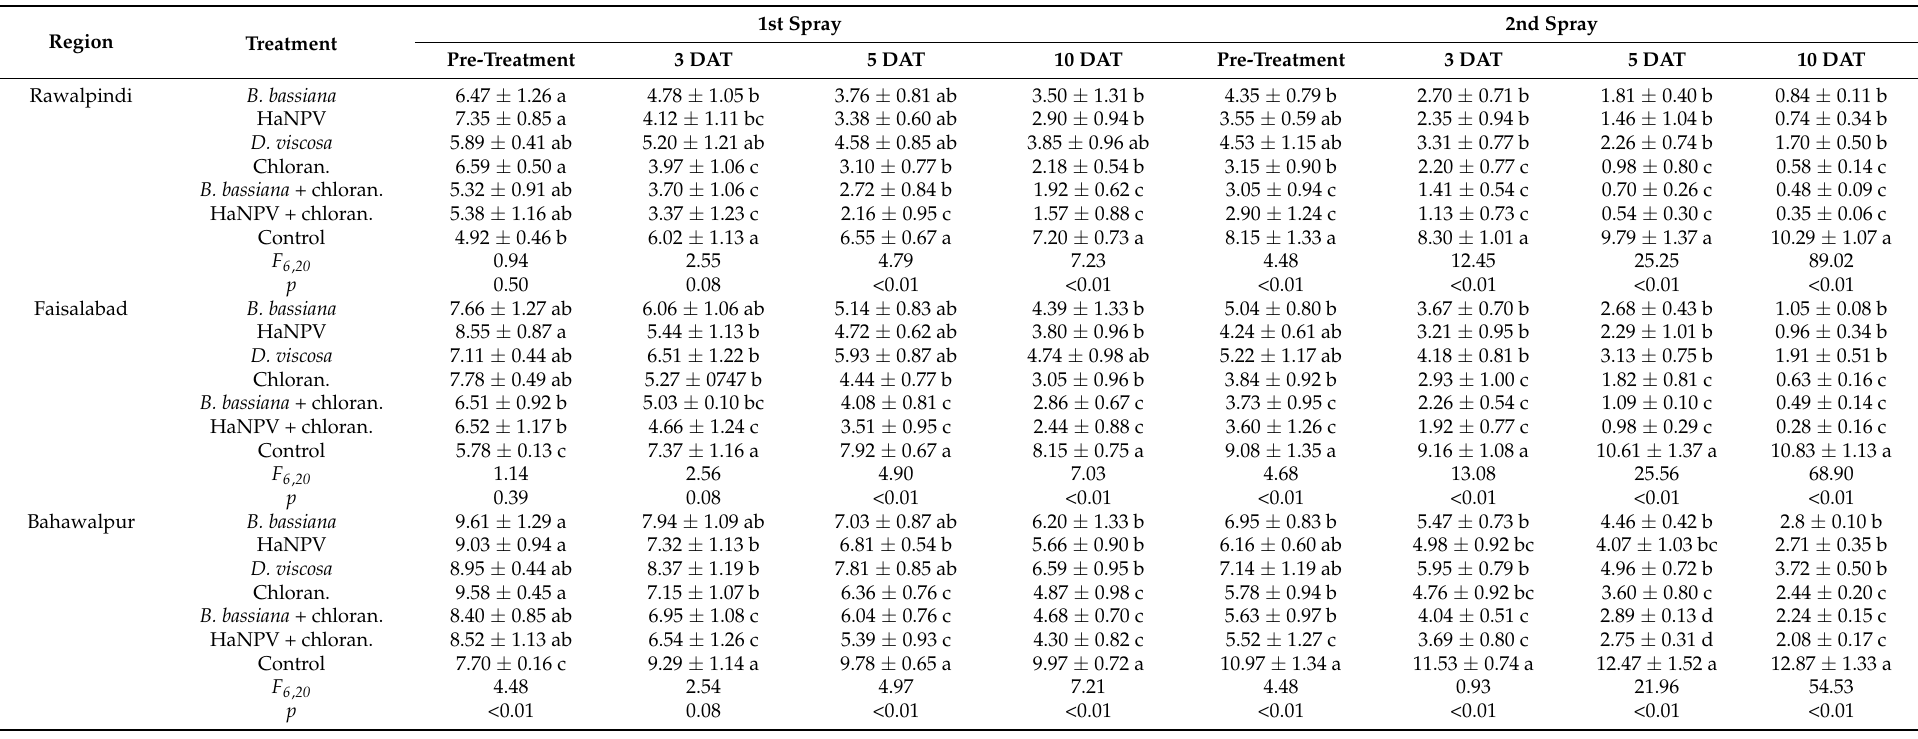
Table 2. Mean larval density (larvae per ten plants ± SE) of H. armigera following field application of different biorational and chemical control options based on B. bassiana ; HaNPV; D. viscosa and chlorantraniliprole (chloran.). Means for each location and sampling occasion followed by the same letters are not significantly different from each other; Tukey-Kramer HSD test at p =